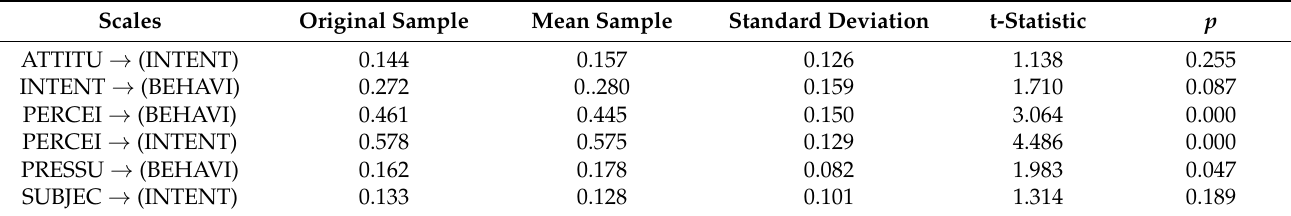
Table 3. Significance of trajectory coefficients (beta).